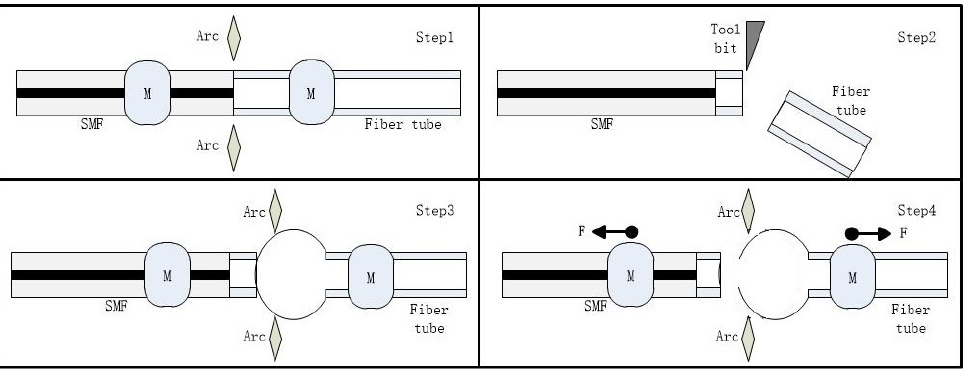
Figure 3. Fabrication of silicon diaphragm miniature fiber Fabry–Perot (FP) cavity sensor.